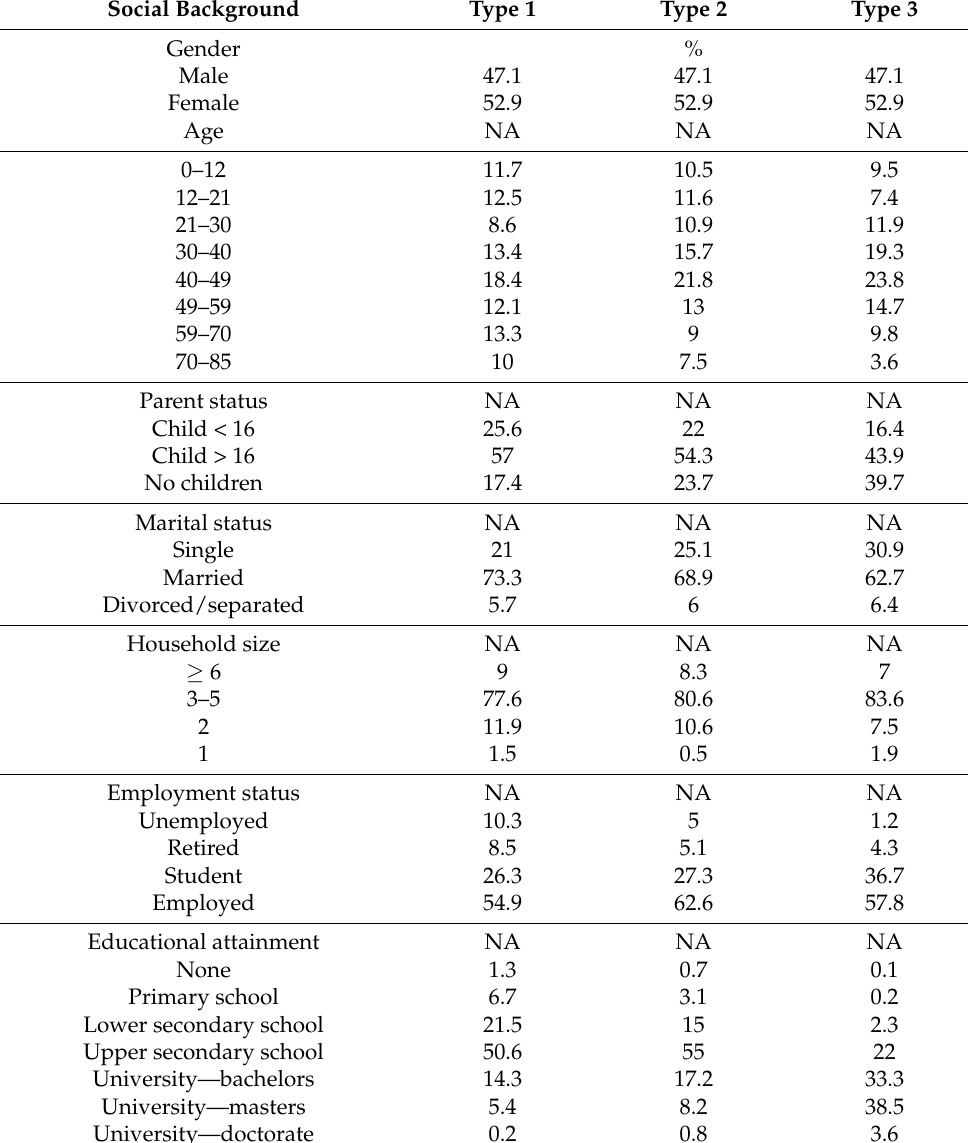
Table 1. Relevant social background characteristics of consumer agents divided into three society types and the distribution in every society